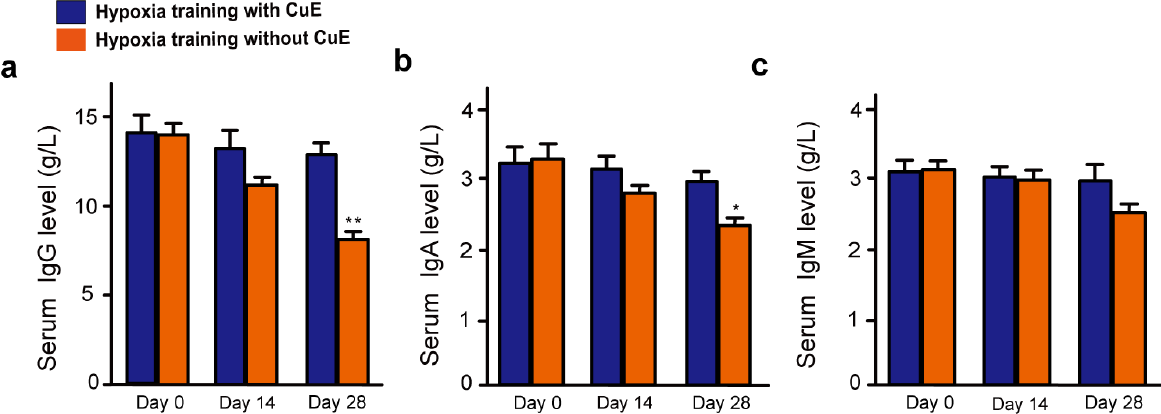
Figure 5. Effects of 4-week altitude training on serum hemoglobin of basketball athletes. Results are presented as means ± SEM (n=6 each group). ** P < 0.02, * P < 0.05 versus hypoxia training ones treated with CuE.